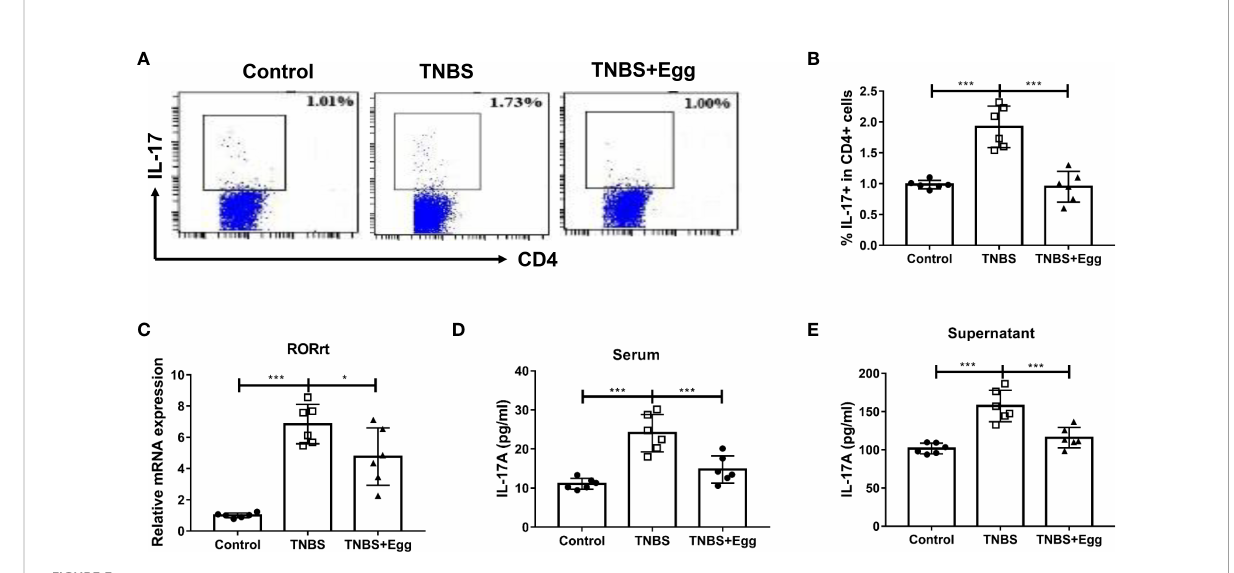
FIGURE 3 Pre-exposure to S. japonicum eggs downregulated Th17 immune response in the TNBS-induced experimental colitis. The proportion of IL-17+ Th17 in spleen CD4+ T cells (A, B) . The mRNA expression level of Th17 speci fi c transcription factor ROR g t in spleen (C) . The concentration of IL- 17A in serum (D) and in splenic supernatant (E) . Data are expressed as means ± SEMs based on 6 mice in each group and from 2 independent experiments. Asterisks mark signi fi cant differences among different groups (* P < 0.05, *** P <